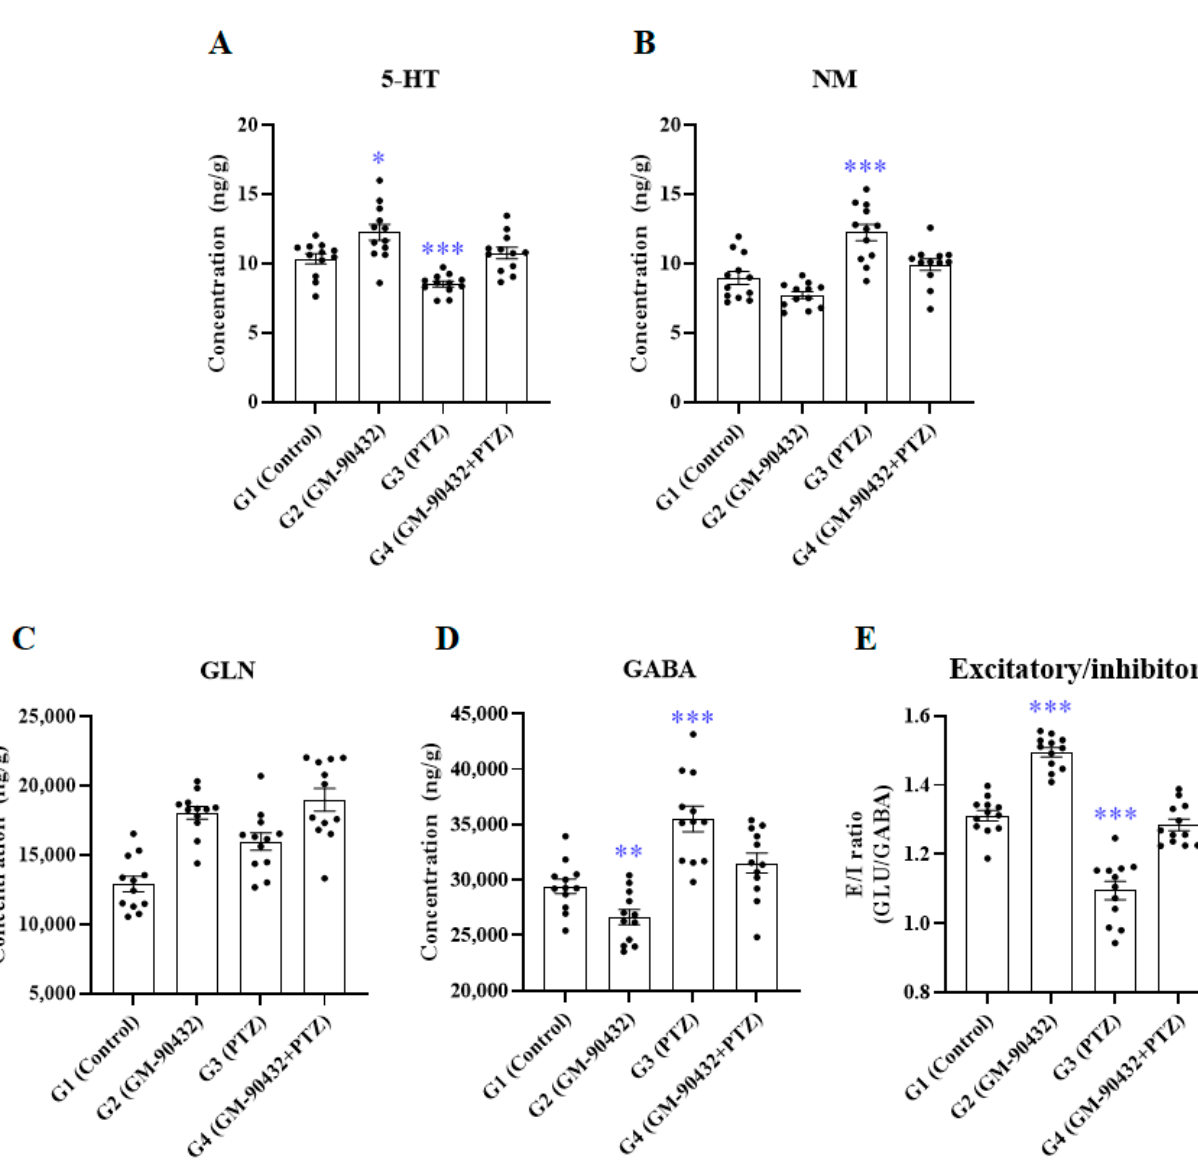
Figure 2. The levels of 5-HT ( A ), NM ( B ), GLN ( C ), and GABA ( D ), and excitatory/inhibitory ratio ( E ) in brain samples of zebrafish exposed to GM-90432, PTZ, or PTZ following pretreatment with GM-90432. Values represent means ± standard error of the mean (SEM) of 12 samples. Significance between control and exposure groups is indicated by * p < 0.05, ** p < 0.01, and *** p < 0.001.